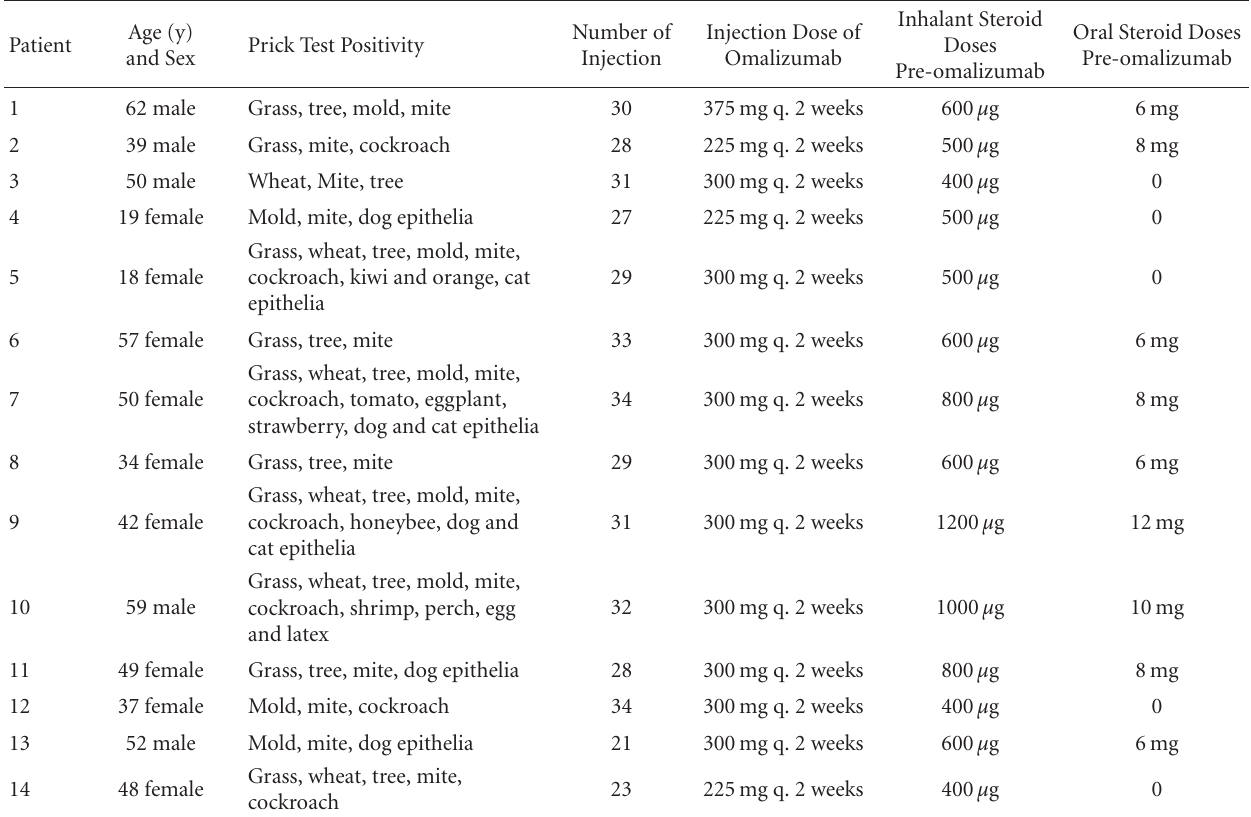
Table 1: Demographics of severe persistent asthma patients (Group I).